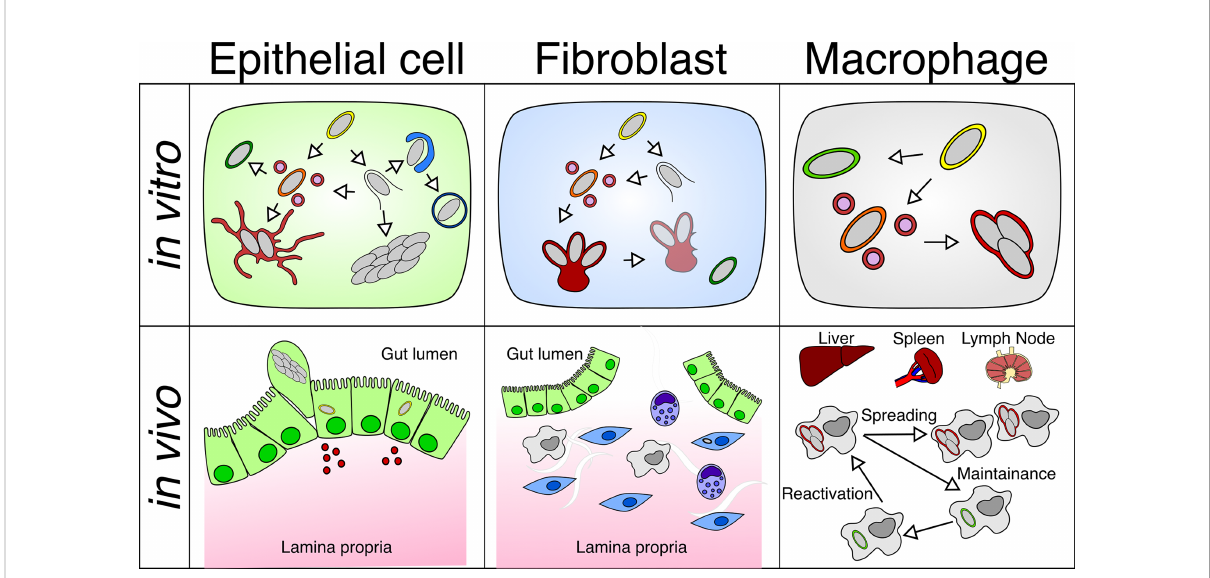
FIGURE 2 Differential behavior of Salmonella within different cell types in vitro or in vivo : S . Typhimurium adopts different intracellular lifestyles in epithelial cells, fi broblasts and macrophages under in vitro and in vivo conditions. (Top left) S . Typhimurium propagates inside the SCV or the host cytosol of the epithelial cell, which is linked to different replication rates. (Top middle) S . Typhimurium only replicates within the aggresome, and S . Typhimurium detached from the aggresome can persist in fi broblasts. (Top right) S . Typhimurium undergoes a replicative or dormant lifestyle inside the SCV of macrophages. (Bottom left) Fast replicating S . Typhimurium leads to the activation of in fl ammatory pathways in the epithelium, which causes the extrusion of epithelial cells harboring fast-growing S . Typhimurium and the release of in fl ammatory cytokines. (Bottom middle) S . Typhimurium resides in a small fraction of fi broblasts in the gut lamina propria. (Bottom right) S . Typhimurium are found in macrophages residing in the liver, spleen, and mesenteric lymph node, where S . Typhimurium harbors both replicating and dormant lifestyles that contribute to the dispersal and persistence of Salmonella in the